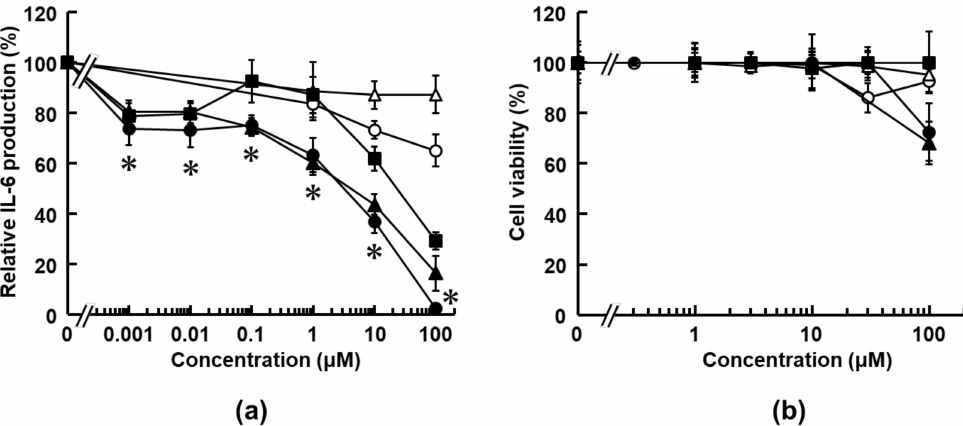
Figure 3. Anti-inflammatory activities of 6M3SC derivatives in HMGB1-stimulated RAW264.7 cells. ( a ) The cells were treated with indicated concentrations of each compound: 0 (open circle), 1 (open triangle), 2 (closed square), 3 (closed circle), and 4 (closed triangle). The IL-6 production (% of control) was measured using the IL-6 ELISA system, as described in the Materials and Methods section. Values are mean ± standard error (SE) for four independent experiments, and the bars indicate the SE values. ( b ) Cell viability was determined by the WST-8 assay, as described in the Material and Methods section. The data are presented as mean ± SE of four independent experiments and * p < 0.05 was accepted as a significant difference compared with untreated samples for compound 3 .